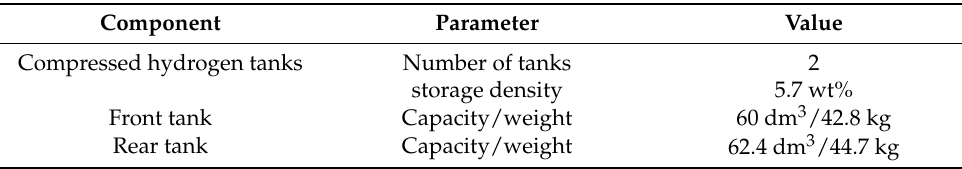
Table 2. Parameters of hydrogen tanks used in Toyota Mirai